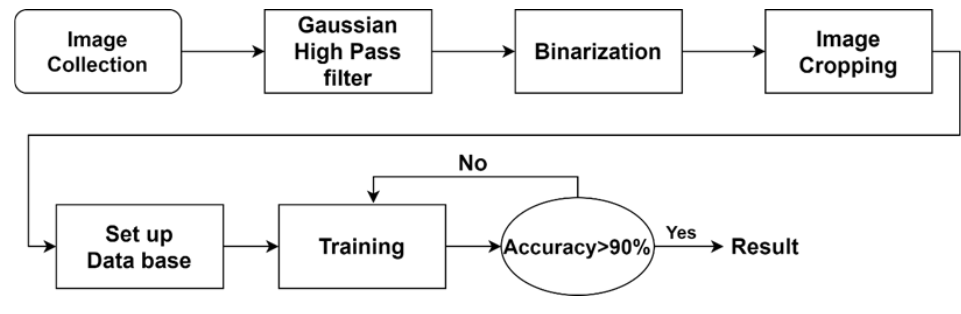
Figure 1. Periapical film database.